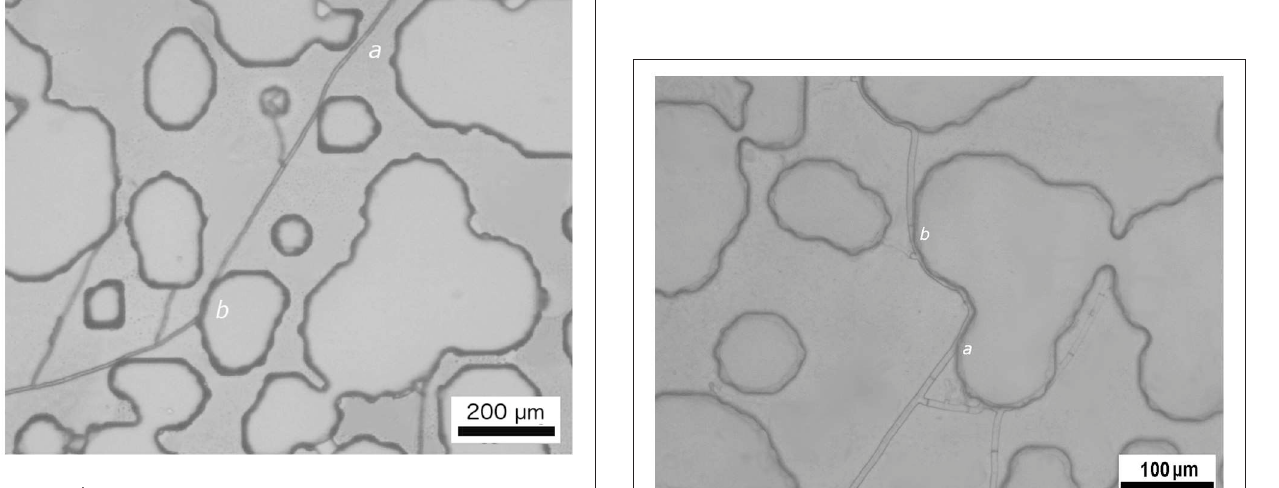
FIGURE 4 | Example of particularly long extension of hyphae in the water-saturated portion of the micromodel. (a) this very long hyphal segment does not show any appearance of branching yet, at the time the picture was taken. (b) At that point, the hypha touches the surface of the pore, and stays in contact with it for a little while, but eventually separates from the surface to return to the pore space.